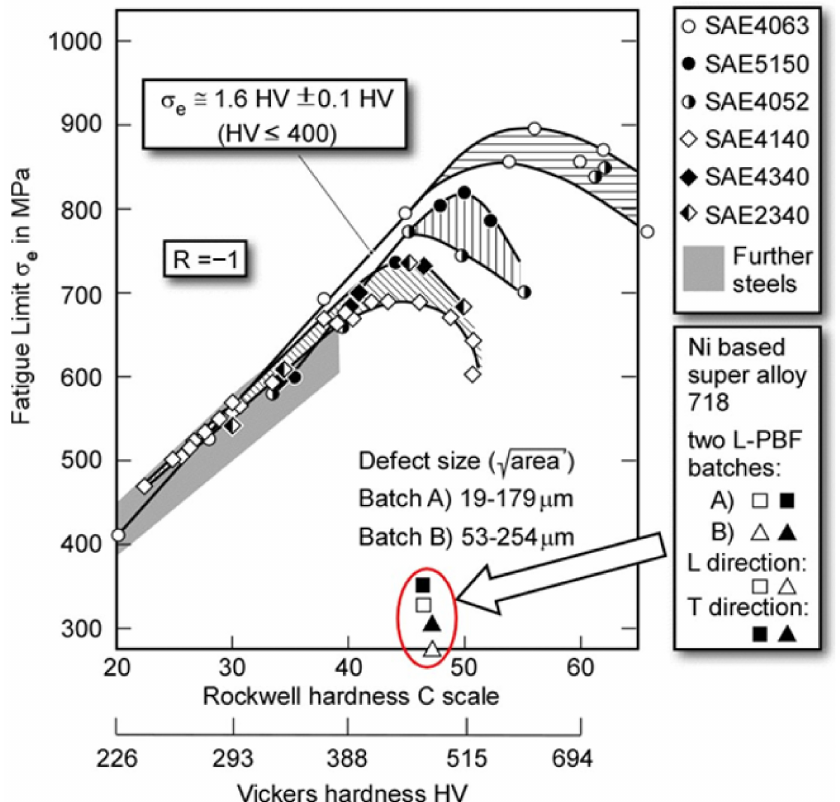
Figure 1. Relationship between the hardness and the fatigue limit of steels [1]. The dots for the L-PBF examples are taken from